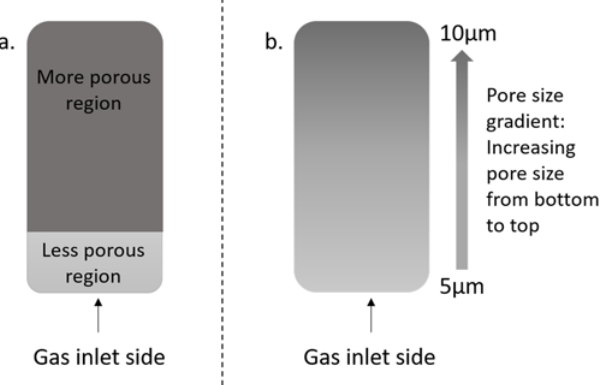
Figure 1. ( a ) Schematic representation of different porosity regions in PTL as studied in [33]. ( b ) Pore size gradient within PTL as in the study from [39].